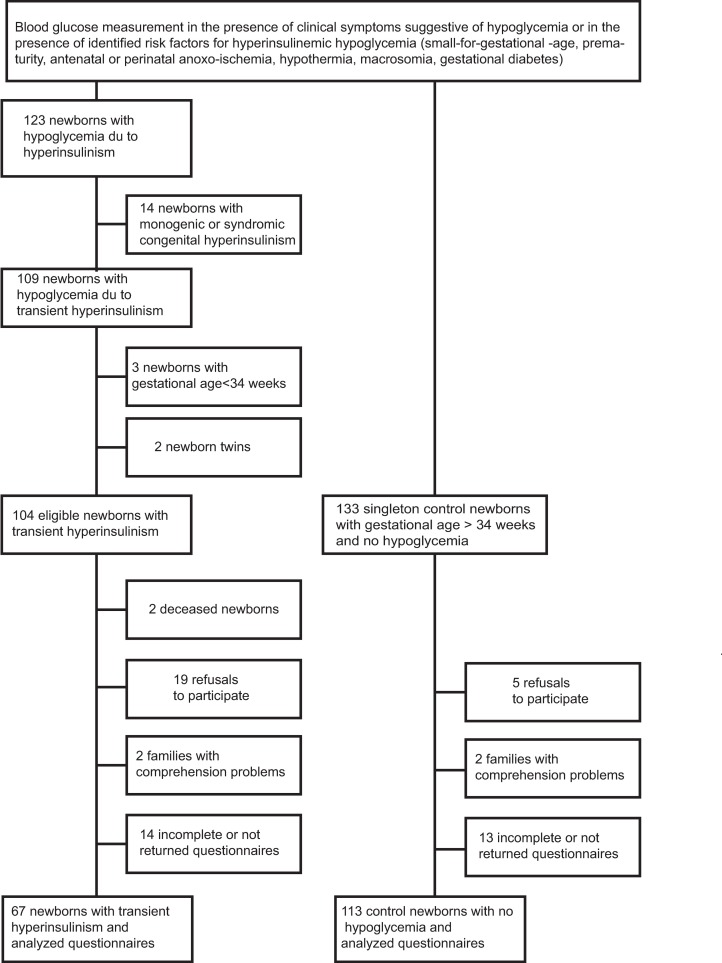
Flow chart of the HI and control groups.BMI: body mass index—HI: hyperinsulinism.